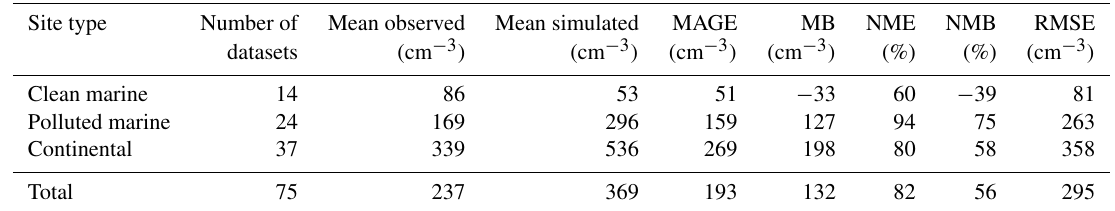
Table 2. Statistical evaluation of EMAC CDNC against 75 observational datasets worldwide, derived from in situ measurements and satellite